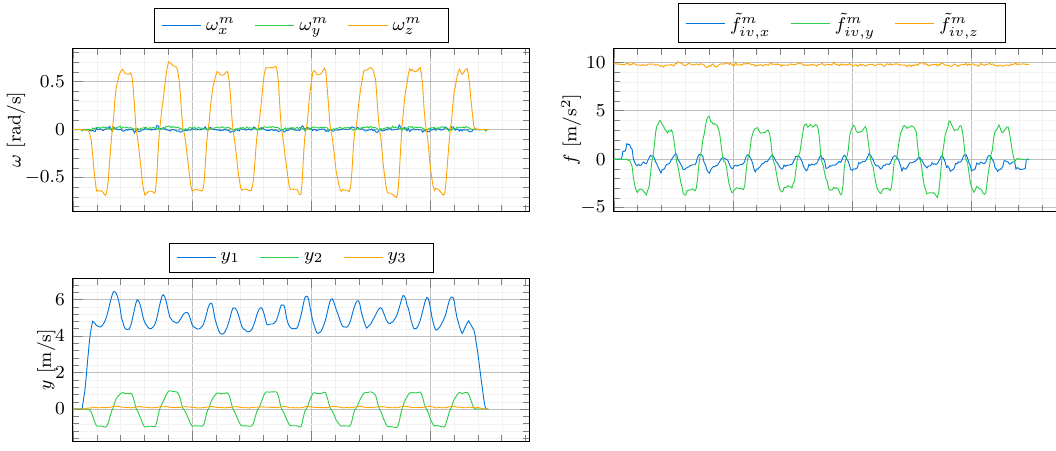
Figure 13. Estimator inputs during a figure eight drive. The bias-free angular velocities ( ω x , ω y , ω z ), the uncorrected specific forces ( ˜ f iv , x , ˜ f iv , y , ˜ f iv , z ), the measurements ( y 1 , y 2 , y 3